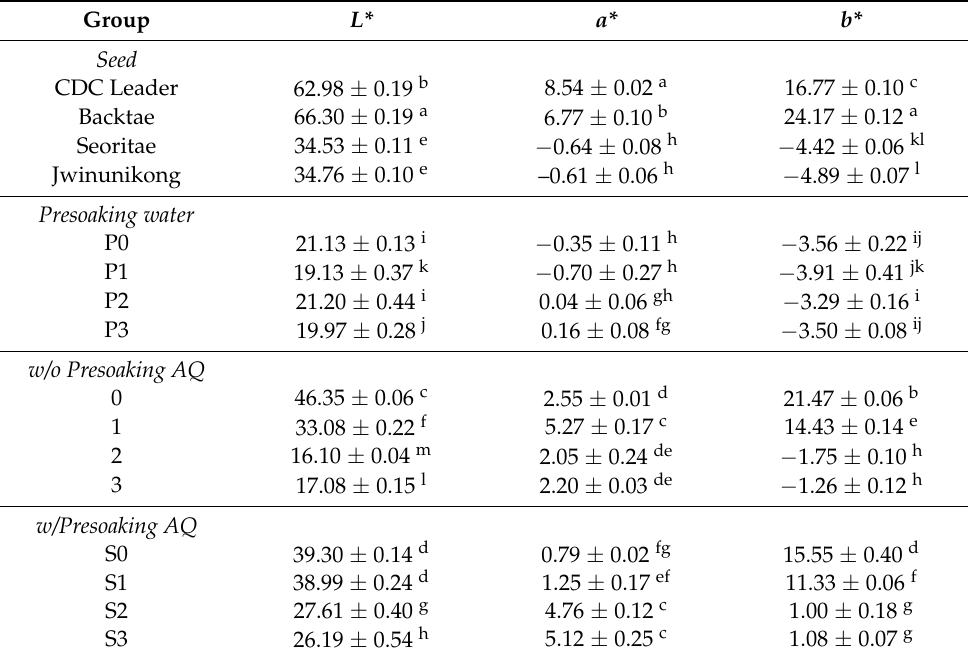
Figure 3. Presoaking water and AQ samples separated from seeds. Top (L–R, circled pictures): the remaining seeds after separation of the AQ liquids after cooking, w/o presoaking AQ samples (0–3), and w/presoaking AQ samples (S0–S3); Bottom (L–R, tube pictures): presoaking water (P0–P3); AQ liquids, w/o presoaking AQ samples (0–3), and w/presoaking AQ samples (S0–S3). AQ samples modified from Shim et al. (2021) [18]. Table 4. Color parameters 1 of all samples used for AQ production.